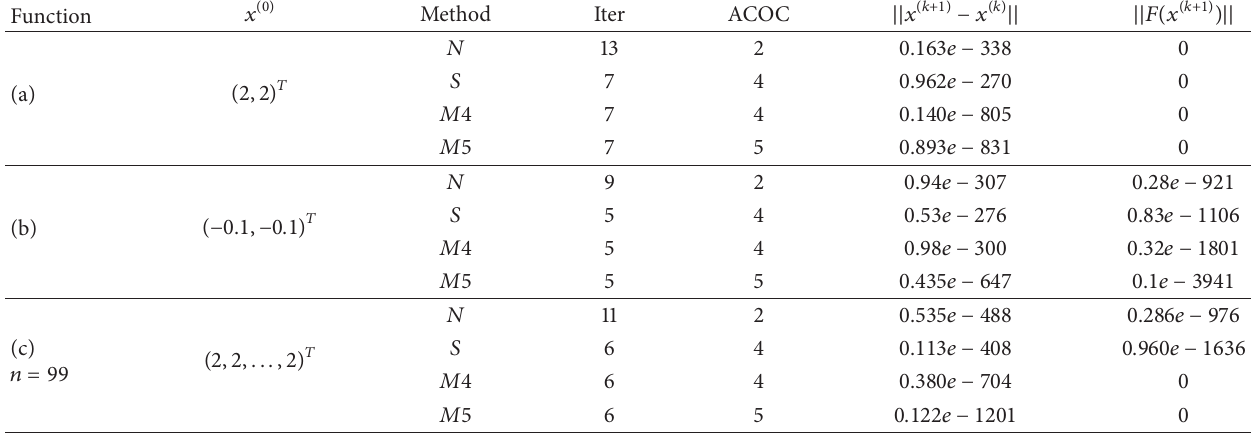
Table 1: Comparative of the iterative methods with nonlinear systems (a) to (c). Function